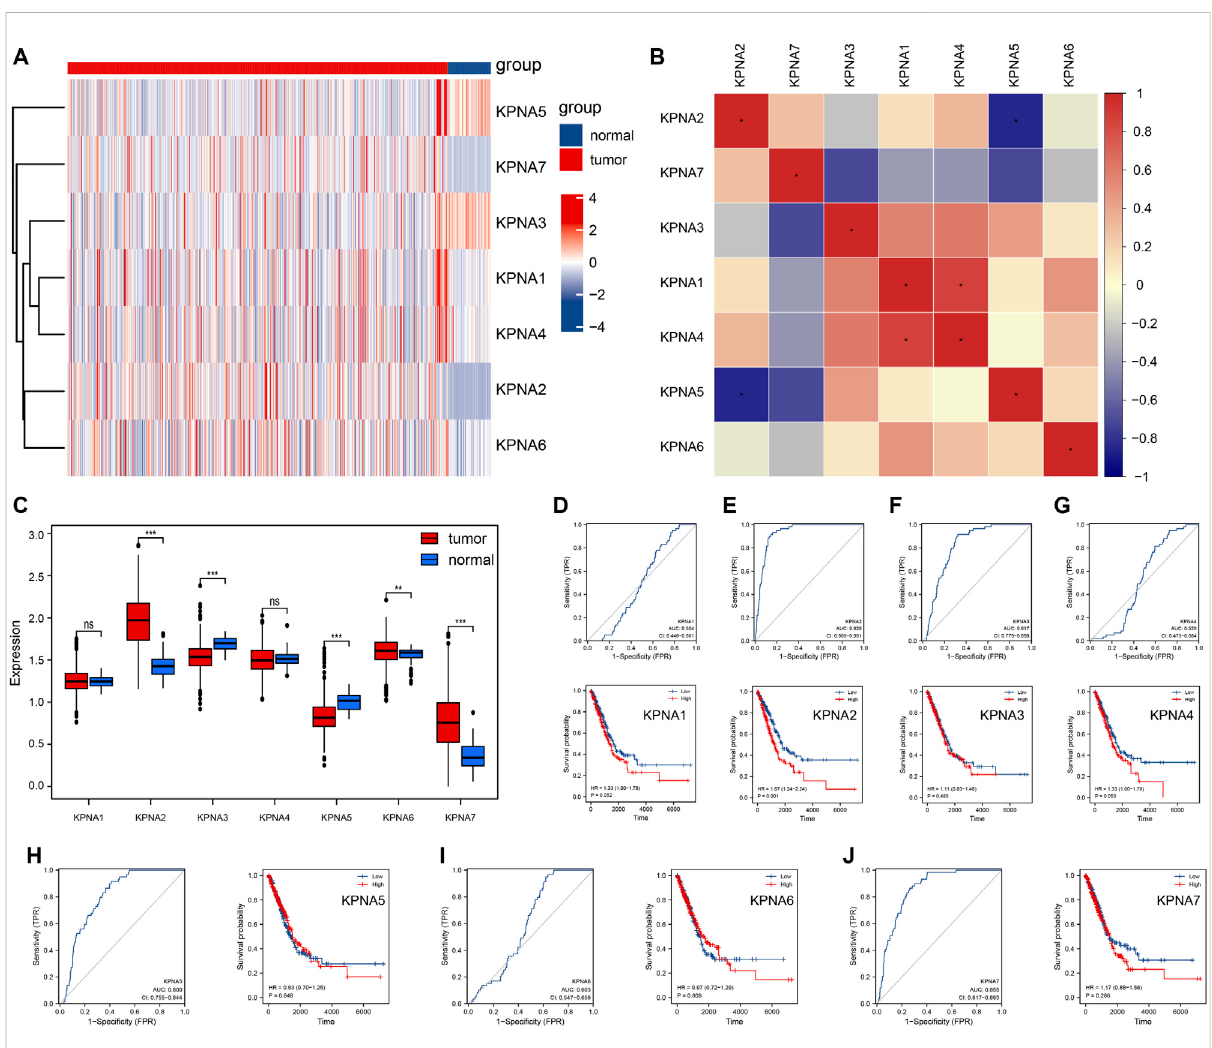
FIGURE 1 Expression patterns of the KPNA family in TCGA-LUAD (A) Heat maps of gene expressions of the KPNA family (B) Heat map of gene-gene correlations in the KPNA family (C) Boxplots of the KPNA family genes between the normal and tumor tissues (D – J) ROC curve showing group differences and the Kapla-Meier curves showing survival differences. * represents p < 0.05; ** represents p < 0.01; *** represents p < 0.001; ns represents no signi fi cant difference ( p >